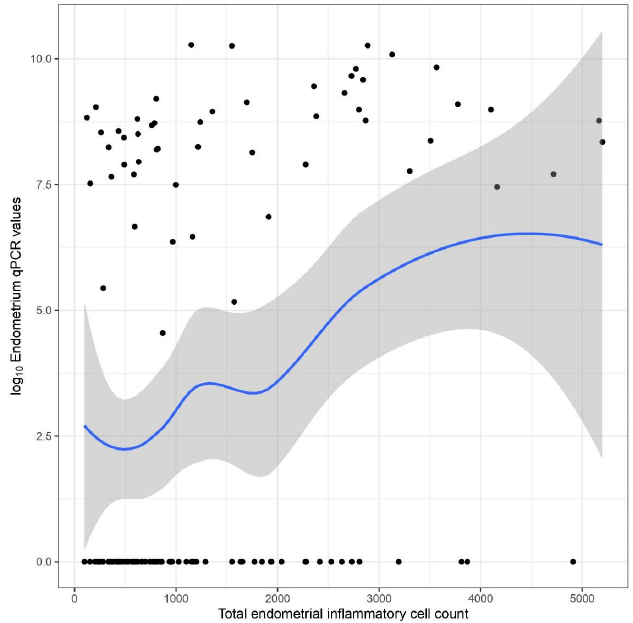
Figure 10. Scatterplot indicating the association between the total inflammatory cell count and endometrial PRRSV GE values. No statistically significant correlation was found between CD163+ cell counts and fetal weights; however, we identified statistically significant negative correlations be- tween the number of CD163+ cells and PRRSV GE values of fetal serum, fetal thymus, endometrium and placenta in the “no_vacc/chall_ H ” group (Pearson’s correlation coeffi- cient = − 0.56, − 0.72, − 0.61, − 0.71, p = 0.0469, 0.0060, 0.0271, 0.0070, 95% CI: − 0.85, − 0.91, − 0.87, − 0.91 and − 0.01, − 0.27, − 0.09, − 0.25, respectively) (Figure 11).